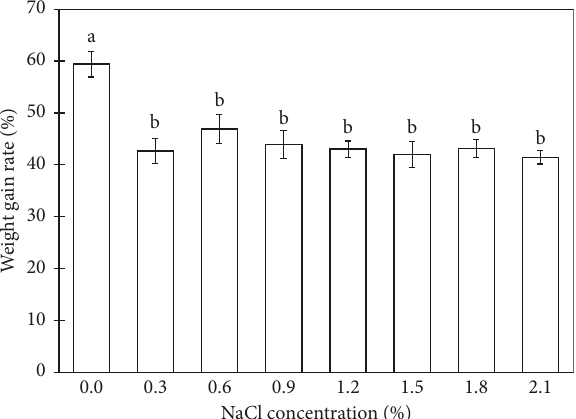
Figure 2: Weight gain rate of Octopus minor immersed in NaCl solutions with different